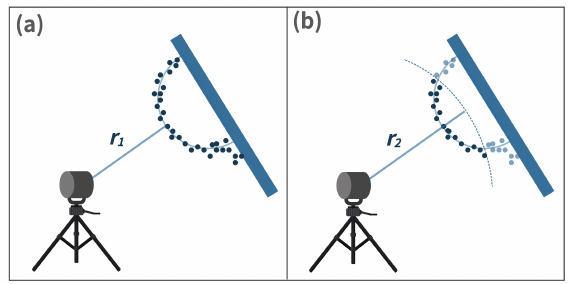
Figure 13. ( a ) Exemplary raw point cloud data from every object in the FoV of DUT. ( b ) Segmented data representing point cloud S i of sphere target.